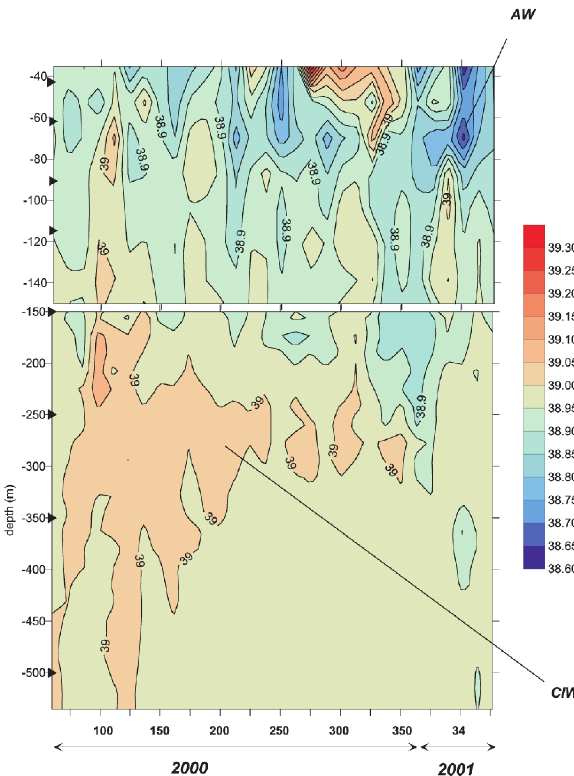
Fig. 6. Time/depth diagram of the salinity for one year of measure- ments. Position of the instrument is shown by a triangle.